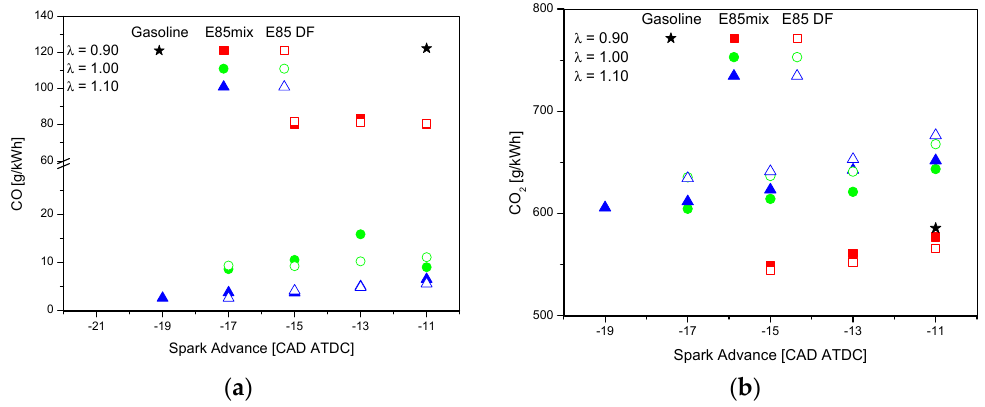
Figure 7. Specific CO and CO 2 emissions against the spark advance at different λ . ( a ) CO; ( b ) CO 2